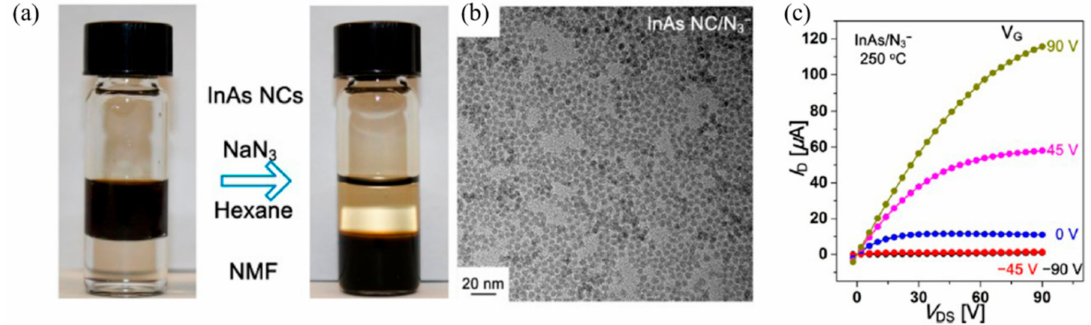
Figure 13. ( a ) Digital image of InAs NCs before and after NaN 3 treatment; ( b ) TEM image of InAs NCs capped with N 3 − ; ( c ) Plot of I/V measurement of N 3 -capped InAs NCs FET devices. Reprinted with permission from [80]. Copyright 2014, American Chemical